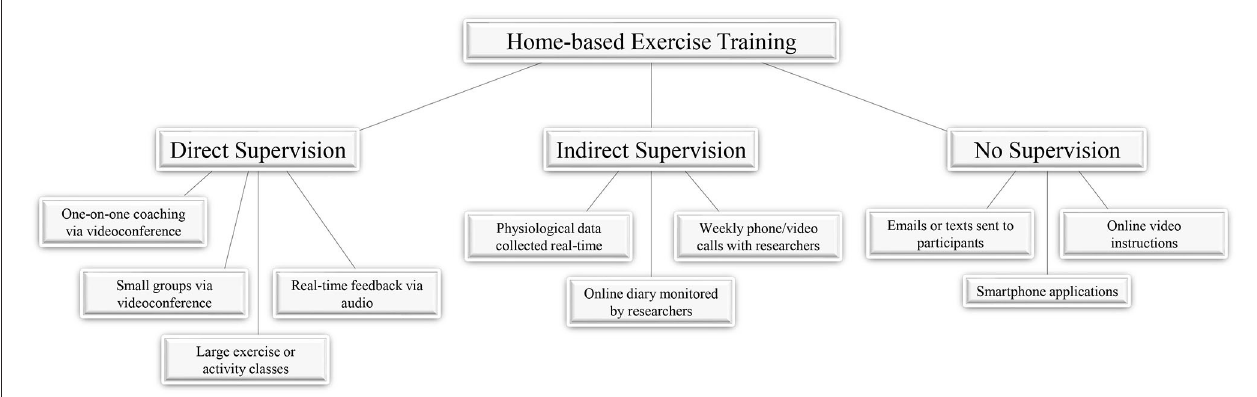
FIGURE 1 | Supervision during home-based exercise. Studies employing home-based exercise as part of training or rehabilitation programs have done so with varying levels of participant supervision. The degree of supervision for exercises can range from direct supervision where participants are being monitored and communicated with in real-time, indirect supervision where participants are being contacted by researchers periodically, or no supervision where participants are given instructions or tools to engage in home-based